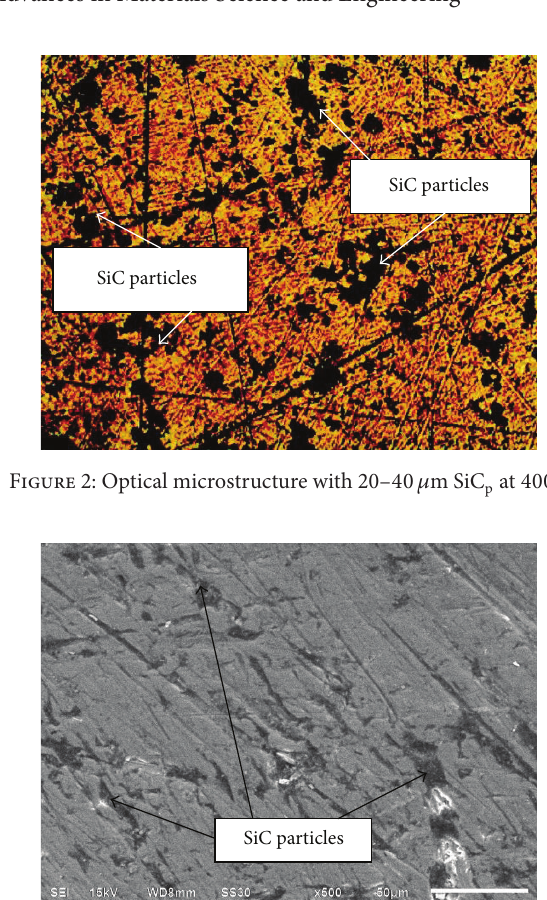
before machining. p